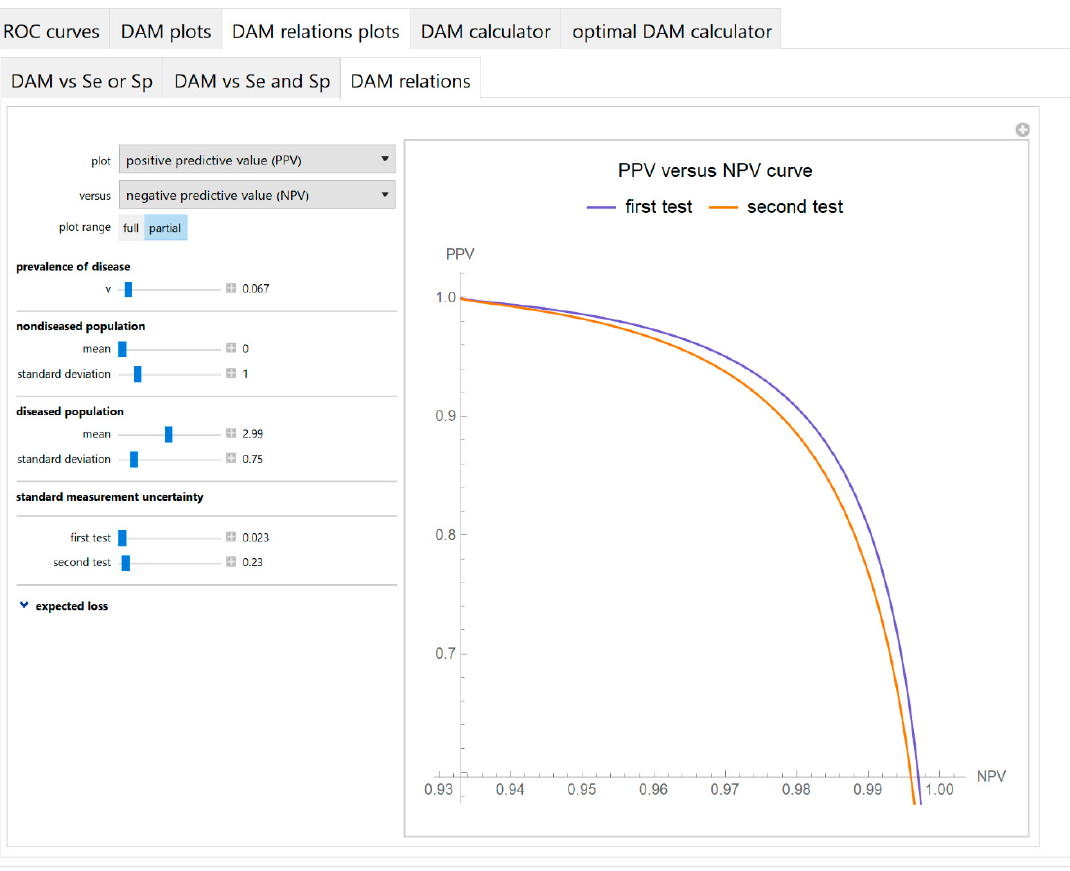
Figure 9. DAM relations plots module, DAM relations submodule screenshot. Positive predictive value ( PPV ) of two screening or diagnostic tests measuring the same measurand with different uncertainties, against negative predictive value ( NPV ) curves plot, with the settings at the left.